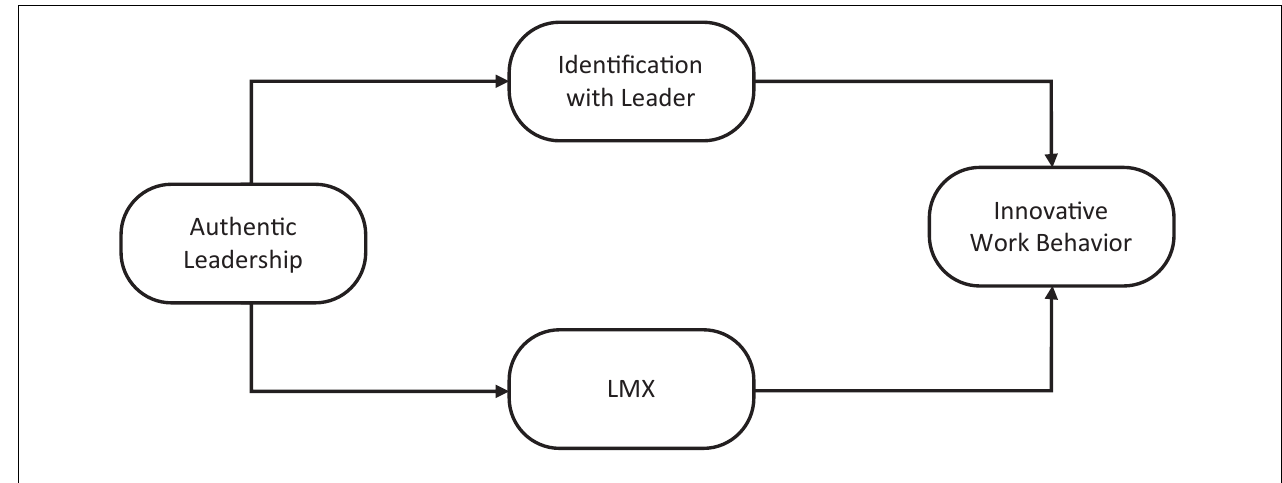
FIGURE 1 | Conceptual framework.